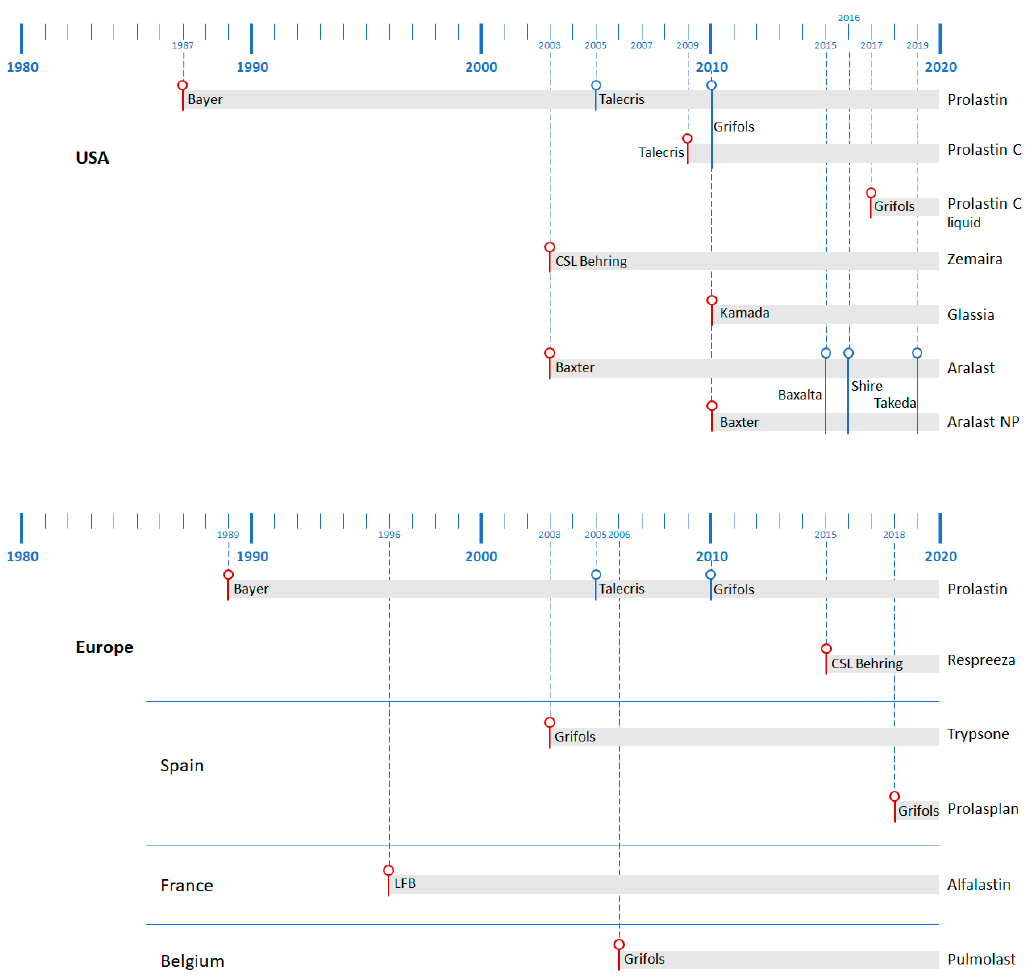
Figure 4. Temporal distribution of the years of approval of augmentative AAT treatments in the USA (upper) and Europe and European countries, with their own presentation (lower). In red: year of initial official approval. In blue: year when company changed. LFB, Laboratoire français du fractionnement et des biotechnologies.